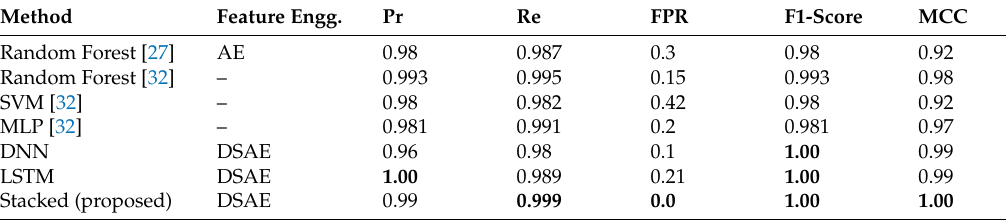
Table 15. Result of evaluation matrices w.r.t. existing approaches on the NetML-2020 test set; best results are indicated with